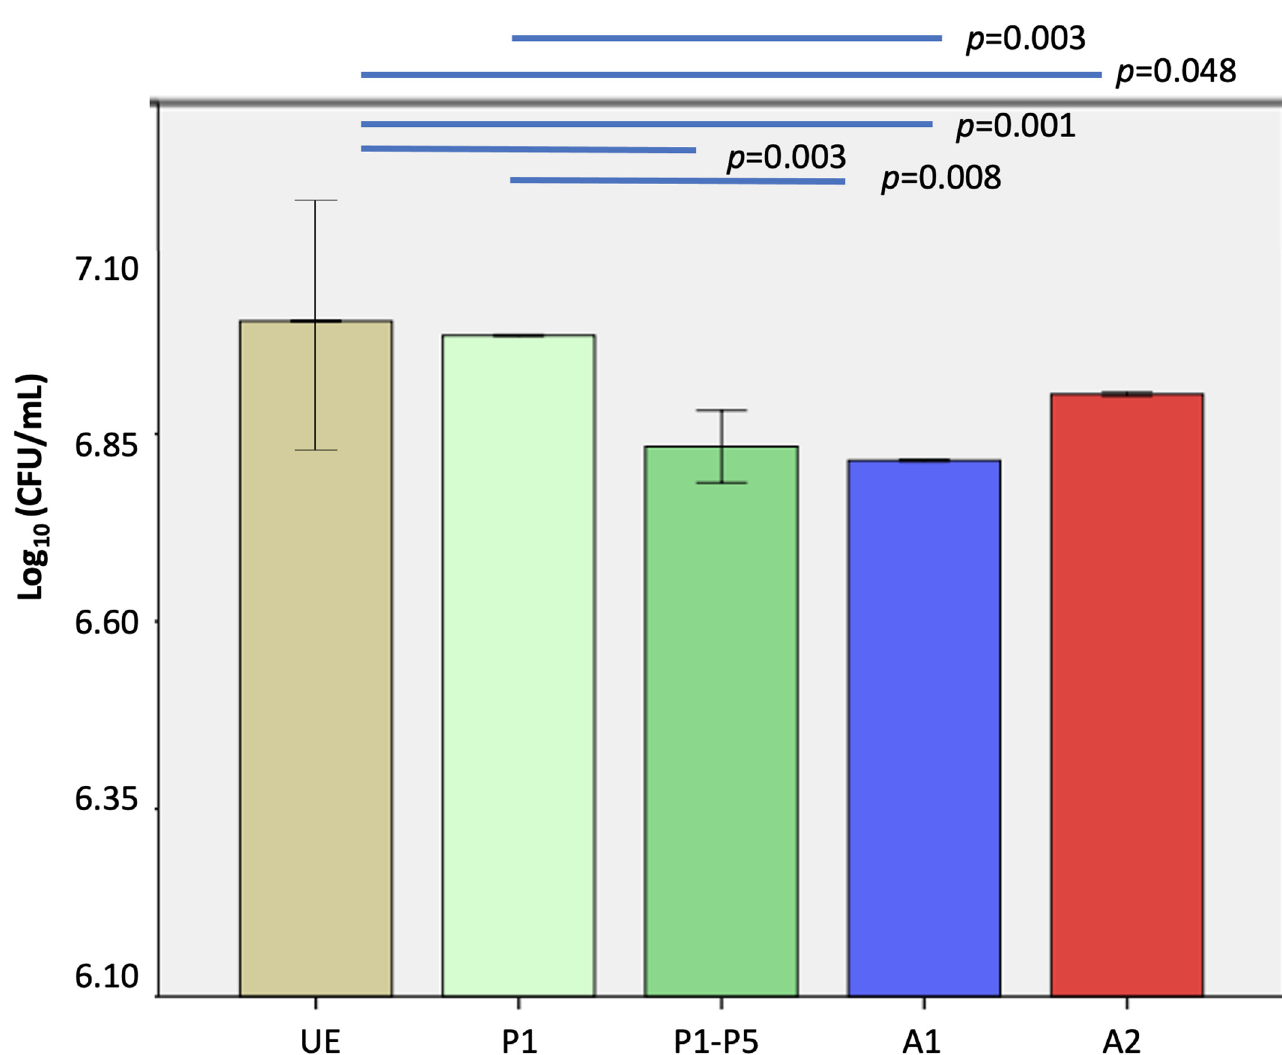
Figure 2. Comparison of the viable planktonic Candida albicans Log 10 CFU/mL (error bars show ± standard deviation) after treatment with CMFs Antibacterial protocol, with different times of exposure.